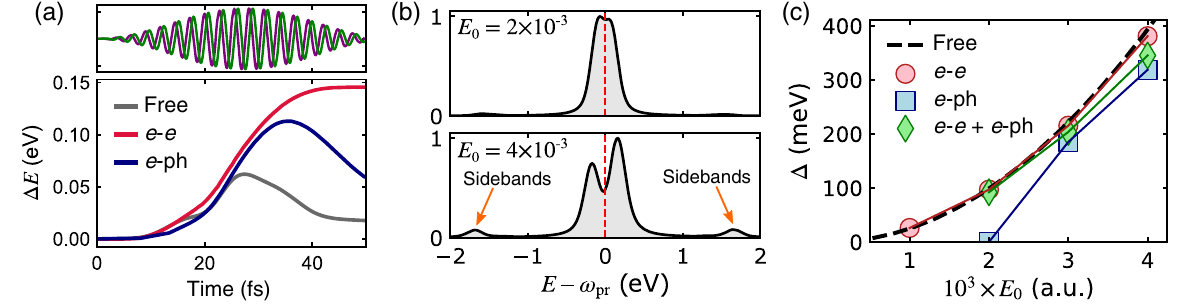
FIG. 4. (a) Time-dependent kinetic energy and shape of the pump pulse. The components of the circular pump fields are reported in ; Δ t Þ [cf. Eq. (8)] at the Dirac point, including e - e and e -ph interactions. purple ( x ) and green ( y ). (b) Photoemission spectra I ð k ¼ K; ε f 30 optical cycles. (c) Floquet gap Δ as a function of the pump field strength extracted from the spectra We use a pump pulse with N c ¼ in (b) and Fig. 3(b). For the case of e -ph scattering, the broad spectra do not allow for an unambiguous determination of a